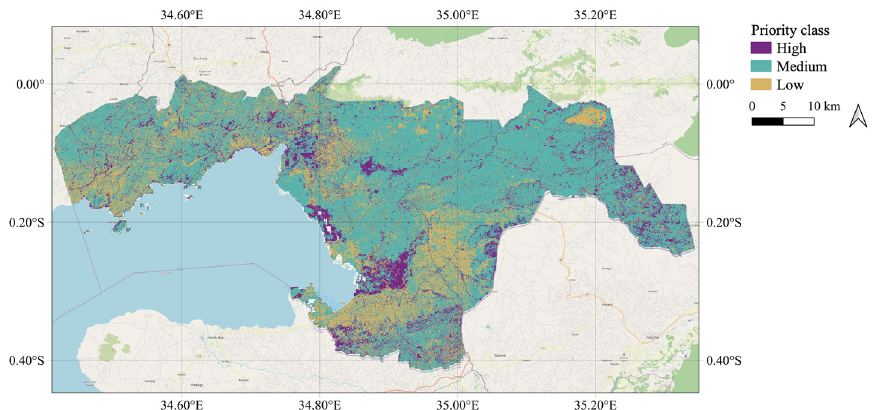
Figure 11. The extent of priority land available for trees and hedgerow plantation around parcels in Kisumu, Kenya.